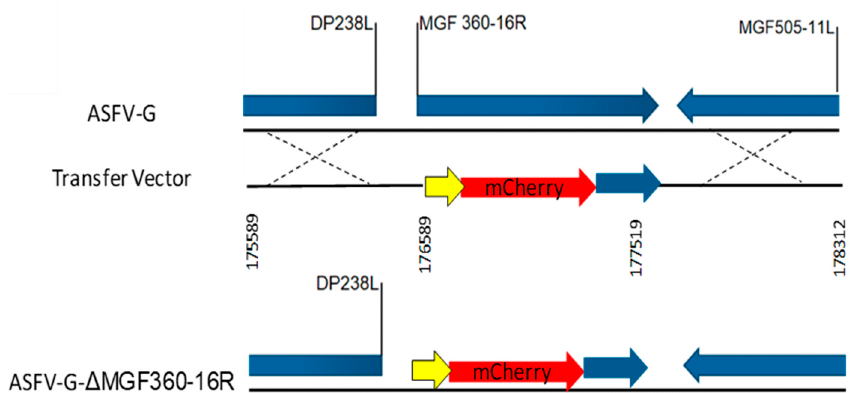
Figure 6. Schematic for the development of ASFV-G- ∆ MGF360-16R. The transfer vector contains p72 promoter, as indicated with the yellow arrow, and an mCherry cassette, shown in red; the nucleotide positions of the flanking left and right arms are indicated and were designed to have flanking ends to both sides of the deletion / insertion cassette, indicated by the dashed lines. The resulting ASFV-G- ∆ MGF360-16R virus with the cassette inserted is shown on the bottom.